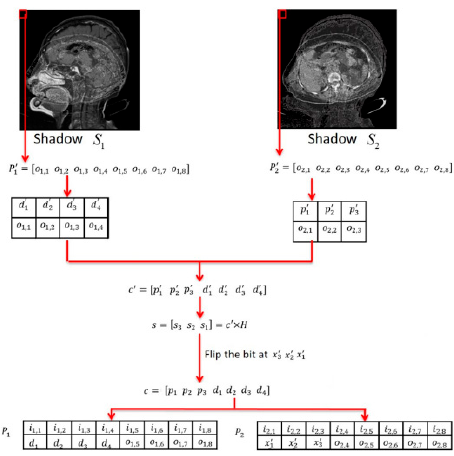
Figure 2. Original image reconstruction process using (7,4) Hamming code. Example 4. In Example 3, it outputs two shadow pixels P’ 1 = [0 0 1 0 1 1 0 1] and P’ 2 = [1 1 0 0 0 1 0 1].